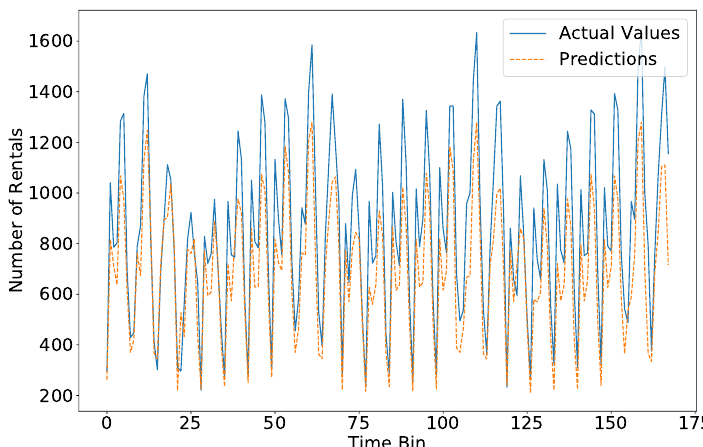
Figure 7. Long-term temporal prediction—Performance of the RFR model in one month of the validation set. The difference in the total number of time bins and the actual number of hours in the month are due to missing data (crawler